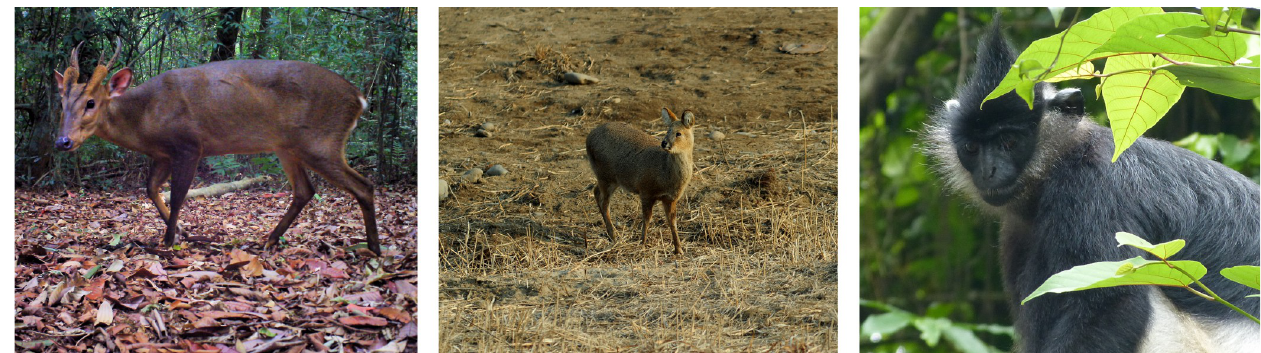
Fig 9. Potential candidates for refaunation in the Tr à ng An Landscape Complex World Heritage Site. Photo credits (left-right): Large-antlered muntjac ( Muntiacus vuquangensis ) (@Association Anoulak); Water deer ( Hydropotes inermis ) (Seong-Won Cho); Delacour’s langur ( Trachypithecus delacouri ) (Ryan